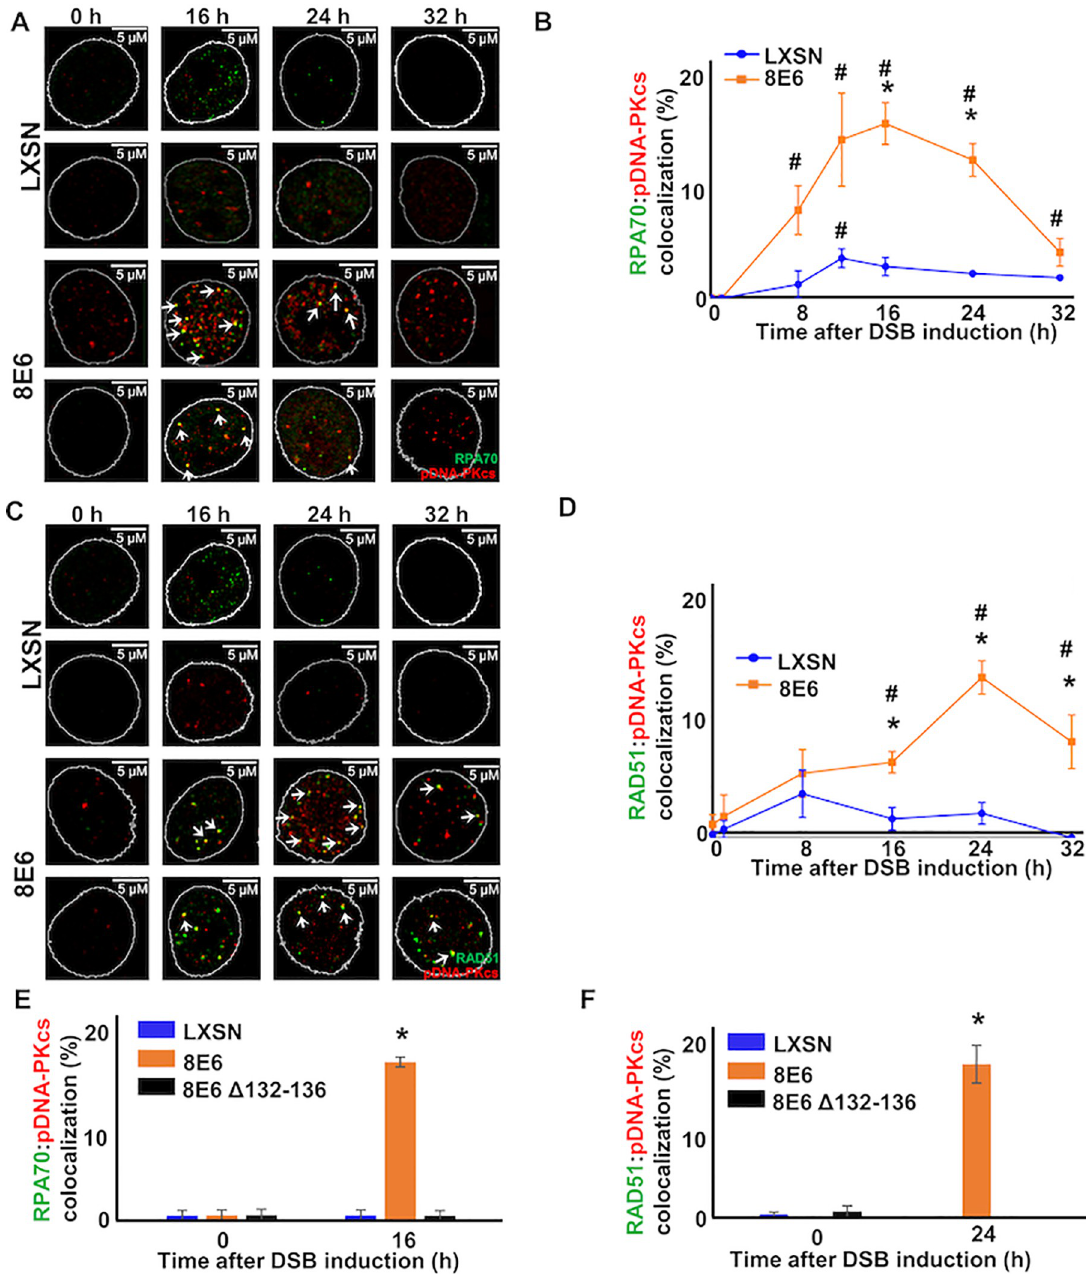
Fig 2. By binding p300, 8E6 allows RAD51 and RPA70 foci to colocalize with persistent pDNA-PKcs foci. (A) Representative images of HFK LXSN and HFK 8E6 cells stained for RPA70 (green) and pDNA-PKcs (red) following zeocin treatment (10 μ g/mL, 10 min). (B) Percentage of HFK cells with colocalized RPA70 and pDNA-PKcs foci. (C) Representative images of HFK LXSN and HFK 8E6 cells stained for RAD51 (green) and pDNA-PKcs (red) following zeocin treatment (D) Percentage of HFK cells with colocalized RAD51 and pDNA-PKcs foci. (E) Percentage of primary HFKs with colocalized RPA70 and pDNA-PKcs foci. (F) Percentage of primary HFKs with colocalized RAD51 and pDNA-PKcs foci. White arrow indicates colocalization. All values are represented as mean ± standard error. The statistical significance of differences between two groups were determined using Student’s t-test. � indicates significant difference between 8E6 and LXSN with same treatment (p < 0.05). # indicates a significant difference (p < 0.05) between control (solvent) and treated group within each cell line. At least 150 cells were counted over three independent experiments. Nuclei were determined by DAPI staining. The edge of this staining is shown by a white line depicting the nucleus.